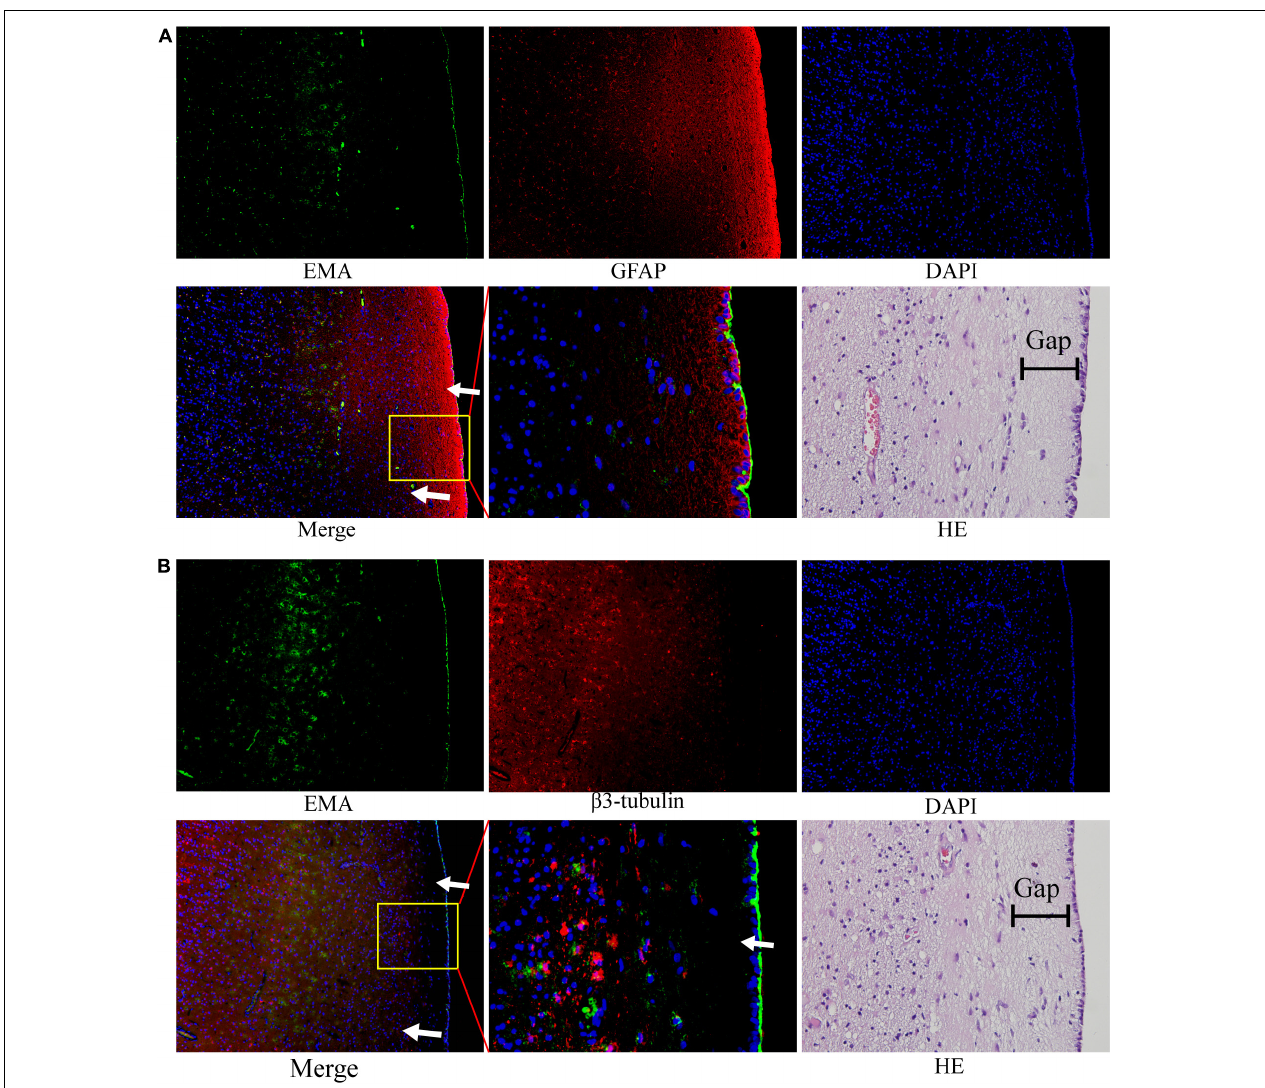
FIGURE 6 | The nature of the subependymal gap was tested by immunofluorescence. All images were taken from the same tissue section. (A) EMA (green) was mainly expressed in the ependymal region and to a lesser extent in tumor cells. The gap with high expression of GFAP (red) was visualized around the ependymal region. (B) EMA (green) was still expressed in the ependymal region, but very little β 3-tubulin expression was observed in the subependymal gap. (The tumor tissue section is from patient No. 4. HE staining corresponds to a similar position as the immunofluorescence image; arrows: subependymal